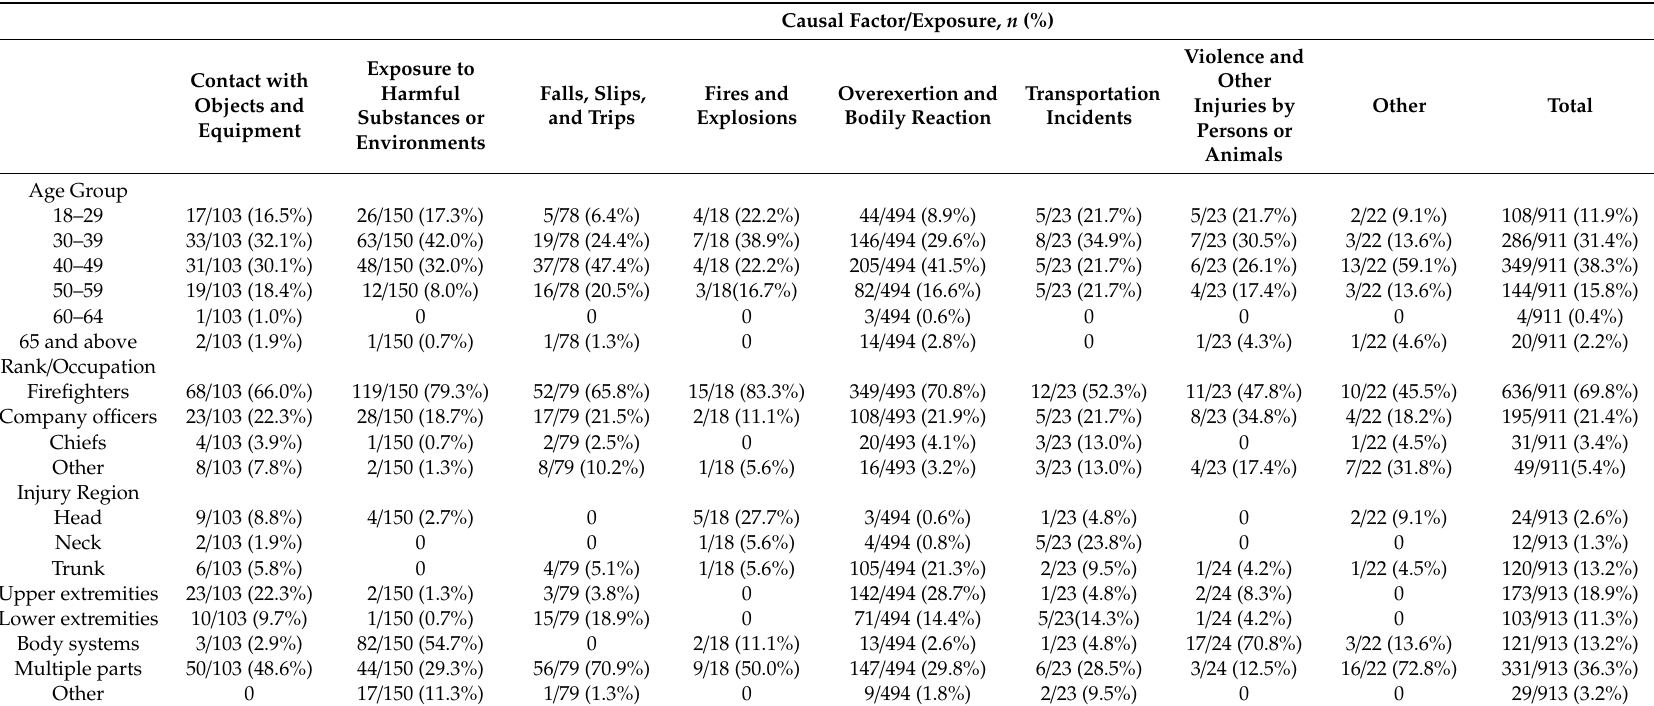
Table 4. Distribution of causal factors / exposures of reported injury by age, rank, injury region,